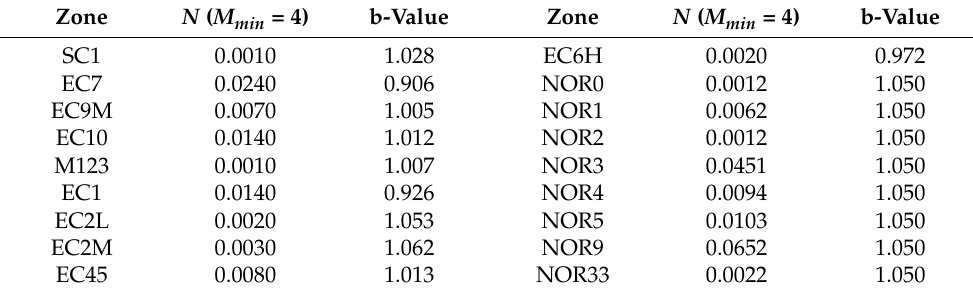
Table 1. Source characteristics for SSM1.